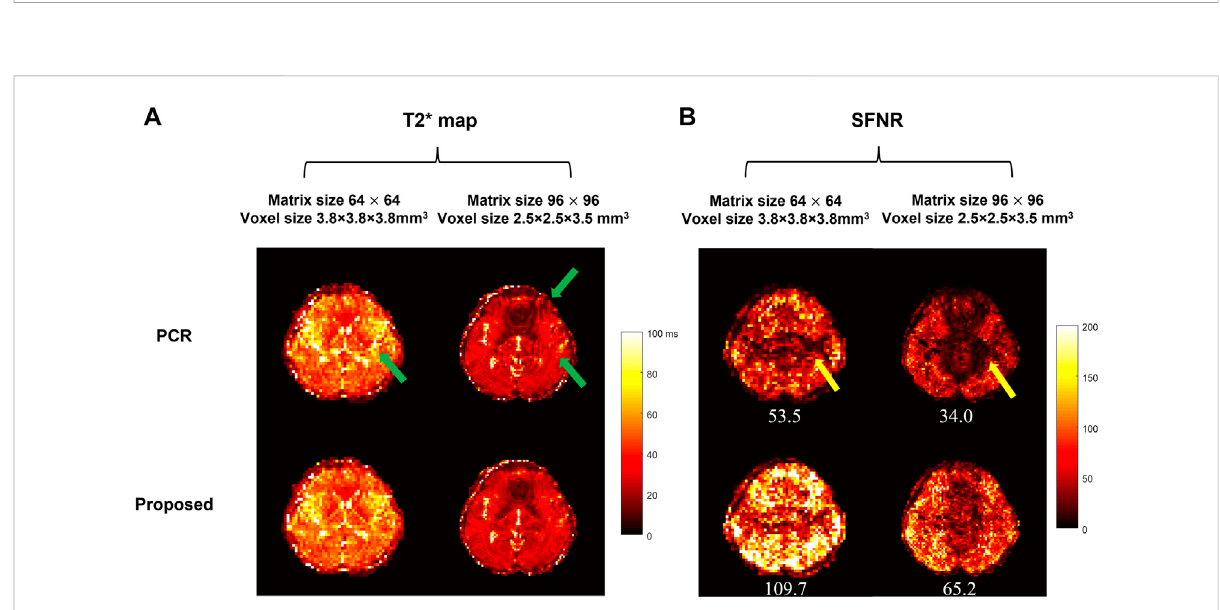
FIGURE 9 Comparison between the conventional interleaved EPI with PCR and the proposed method in multi-echo 4-shot fMRI with two resolutions (64 × 64/96 × 96) and voxel sizes (3.8 × 3.8 × 3.8/2.5 × 2.5 × 3.5 mm 3 ). (A) shows the dynamic T2* maps and (B) shows the SFNR maps of a representative image. The average SFNR value is shown at the bottom of each corresponding SFNR map. The residual aliasing artifact resulting from insuf fi cient suppression of Nyquist ghost are marked in the dynamic T2* map [green arrows in (A) ] and SFNR map [yellow arrows in (B) ] respectively. The proposed method can enable dynamic Nyquist ghost correction for time-series fMRI data without the need of additional internal reference scan. The improved stability of time-course fMRI signal can allow to better detect the small signal change (e.g., 5% – 7% signal change [34]) due to brain